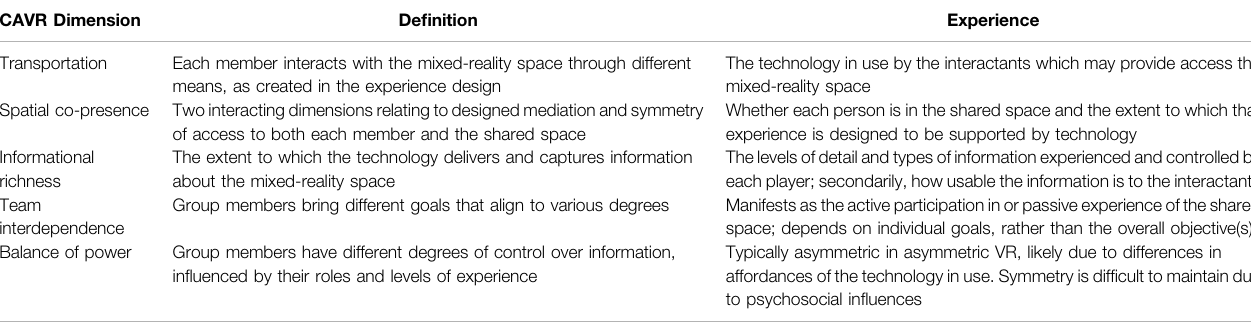
TABLE 5 | Updated de fi nitions and suggested experiences of the fi ve CAVR dimensions of asymmetry. CAVR Dimension De fi nition